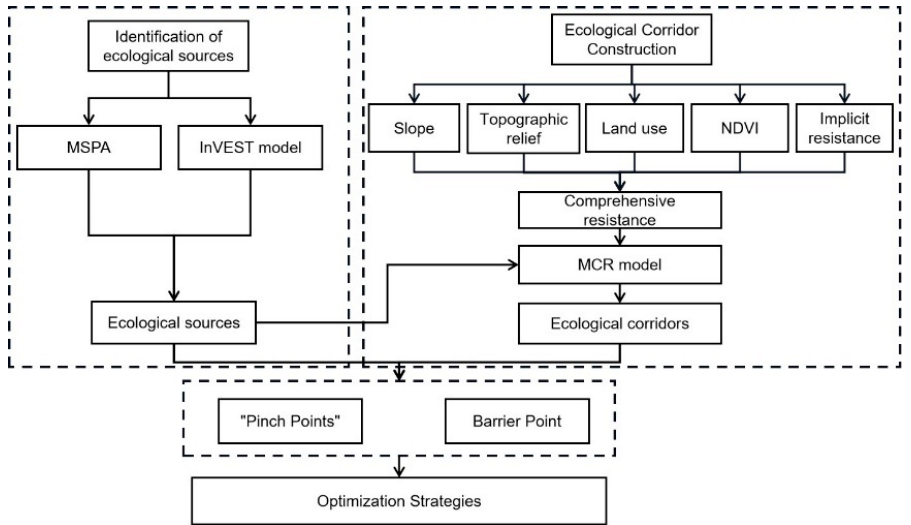
Figure 3. Framework of this study.